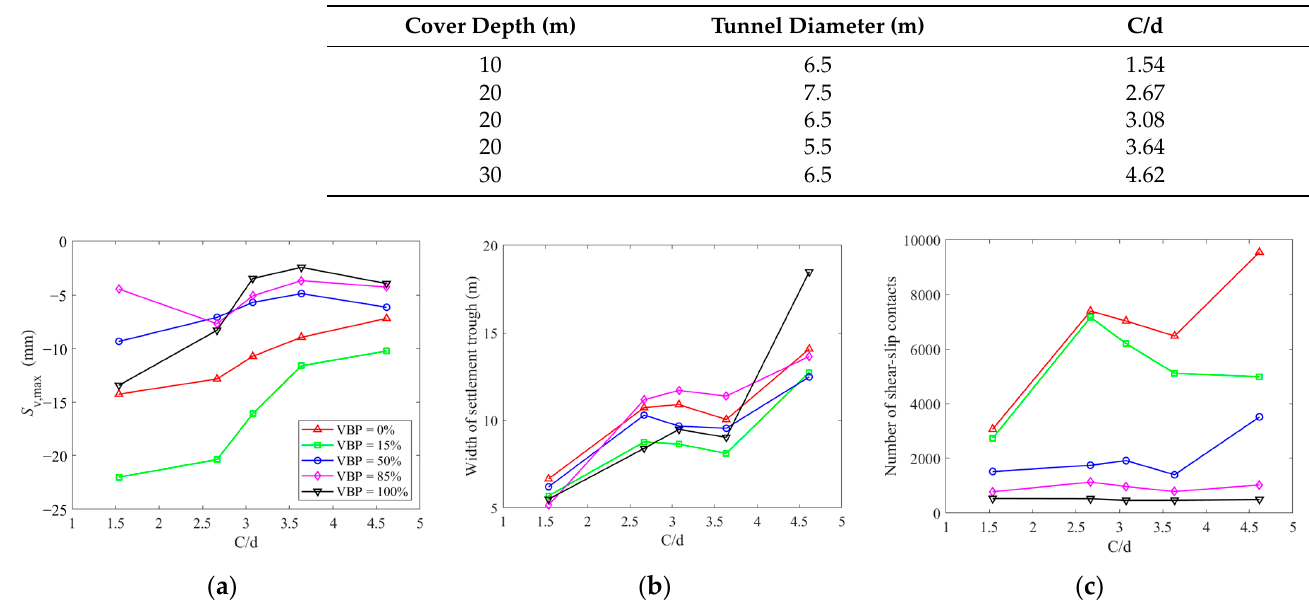
Table 2. The numerical modes with different cover depths and tunnel diameters.